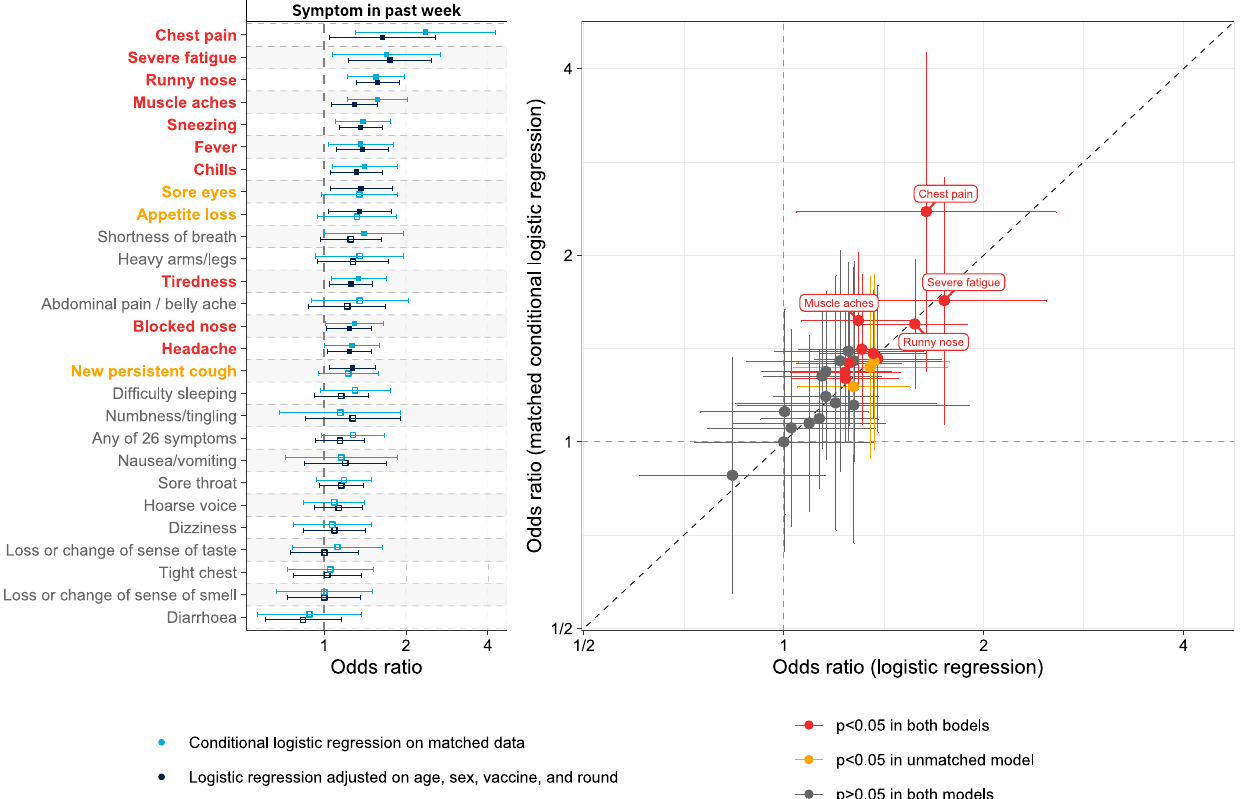
Fig. 4 | ORs for infection with BA.2 vs BA.1 among swab-positive respondents. ORs are derived from (i) logistic regression models with BA.2 vs BA.1 as the binary outcome variable, and presence or absence of any of 26 symptoms as explanatory variables, adjusted for age group, sex, round and vaccination status, among N =5598 swab-positive individuals with either BA.2 or BA.1 in rounds 17 – 19 (5 Jan- uary to 31 March 2022);and (ii) conditionallogistic regression modelswith BA.2 vs BA.1 as the outcome variable among 1510 swab-positive individuals with either the BA.2orBA.1variantinrounds17 – 19,matched1:1onage(±5years),sex,vaccination